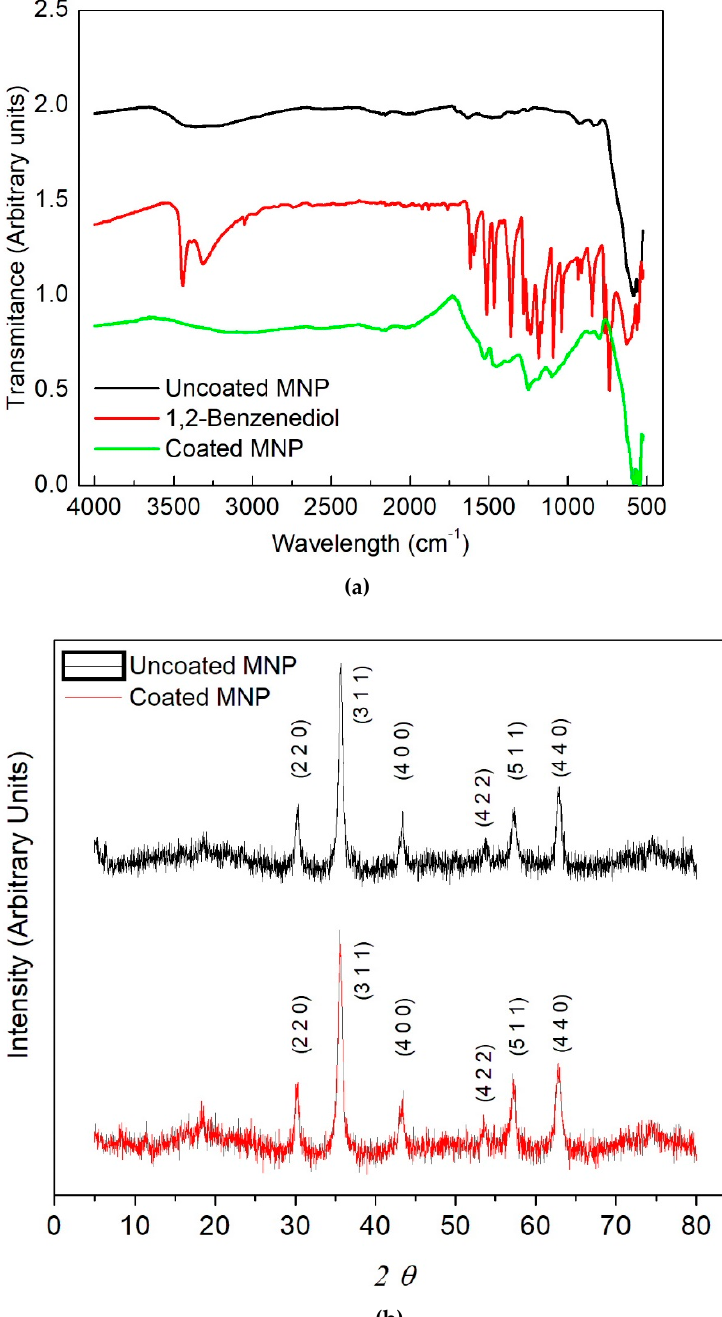
Figure 1. ( a ) FTIR spectra of uncoated MNPs, catechol and coated MNPs; ( b ) XRD spectra of both coated and uncoated MNPs.